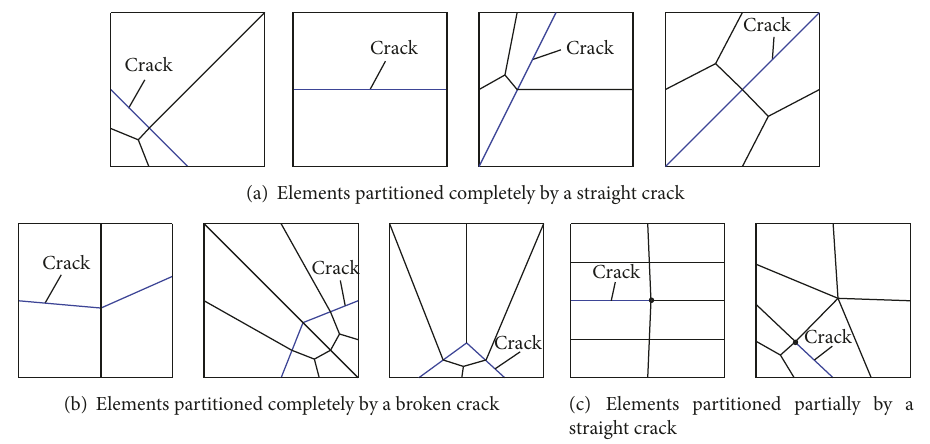
Figure 2: Element partitioning method for these elements containing a discontinuous